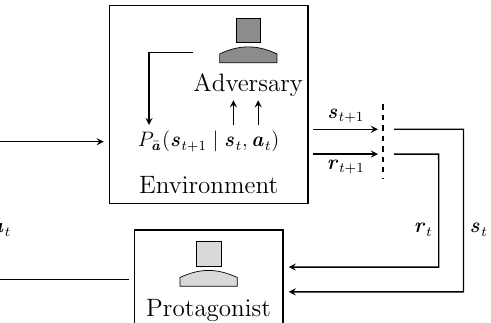
Figure 5. Schematic representation of methods following a transition robust design. The framework considers adversaries taking control of the transition function. The adversary selects a transition function—here described as distribution—from a predefined uncertainty set. This decision is based on the current state of the environment and the action chosen by the